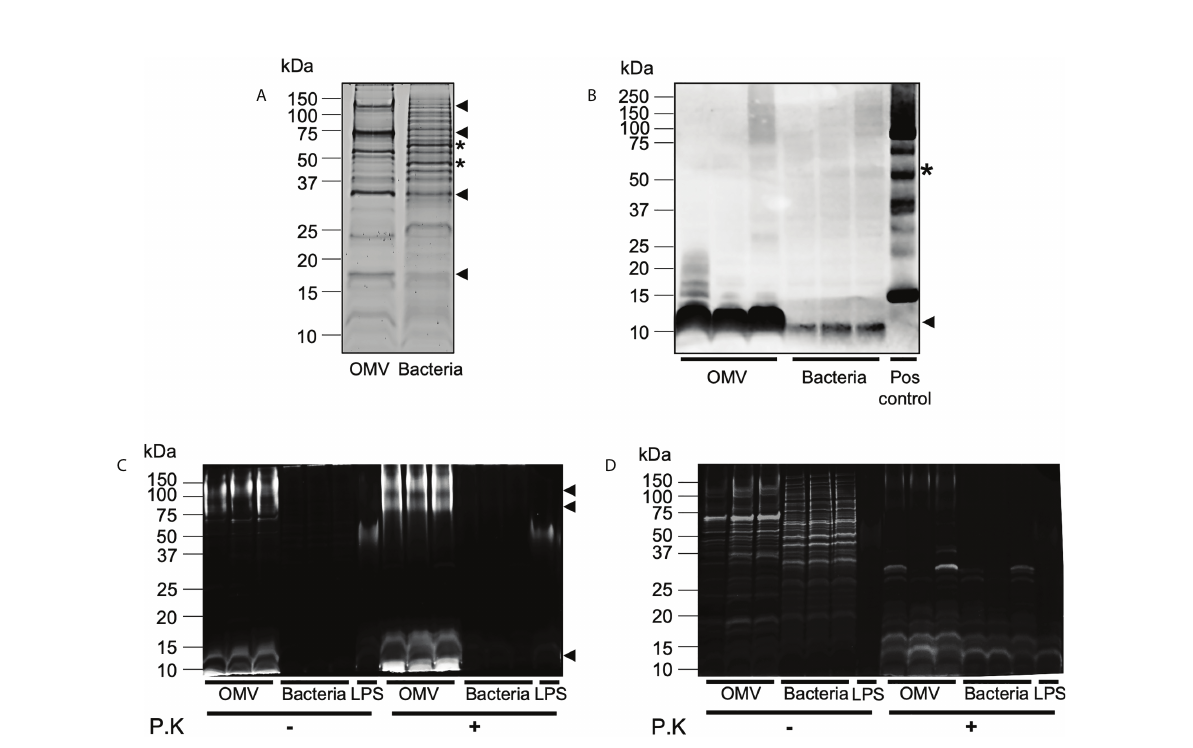
FIGURE 2 B. fragilis OMVs are enriched in protein, peptidoglycan and LPS cargo compared to their parent bacteria. (A) B. fragilis OMVs (10 m g) and B. fragilis bacteria (10 m g) were separated using SDS-PAGE and their protein cargo was stained using Sypro Ruby. Data is representative of three biological replicates. (B) The presence of peptidoglycan cargo associated with B. fragilis OMVs (10 m g) and B. fragilis bacteria (10 m g) was detected using Western immunoblot using an anti-peptidoglycan antibody. Peptidoglycan was used as a positive control (Pos control). Data shows three biological samples of B. fragilis OMVs and B. fragilis bacteria and is representative of three experiments. (C) B. fragilis OMVs and B. fragilis bacteria were treated with Proteinase K (P.K) (+) or not treated as controls (-), and their LPS cargo was detected by staining with ProQ Emerald 300 LPS stain. (D) ProQ Emerald-stained SDS-PAGE gels were counterstained with the protein-speci fi c stain Sypro Ruby. Data in panel C and D represents three independent biological samples of B. fragilis OMVs and B. fragilis bacteria and is representative of three independent experiments. In all panels (A – D) , black arrows represent cargo that is enriched in OMVs compared to bacteria, stars represent cargo that is less abundant in OMVs compared to